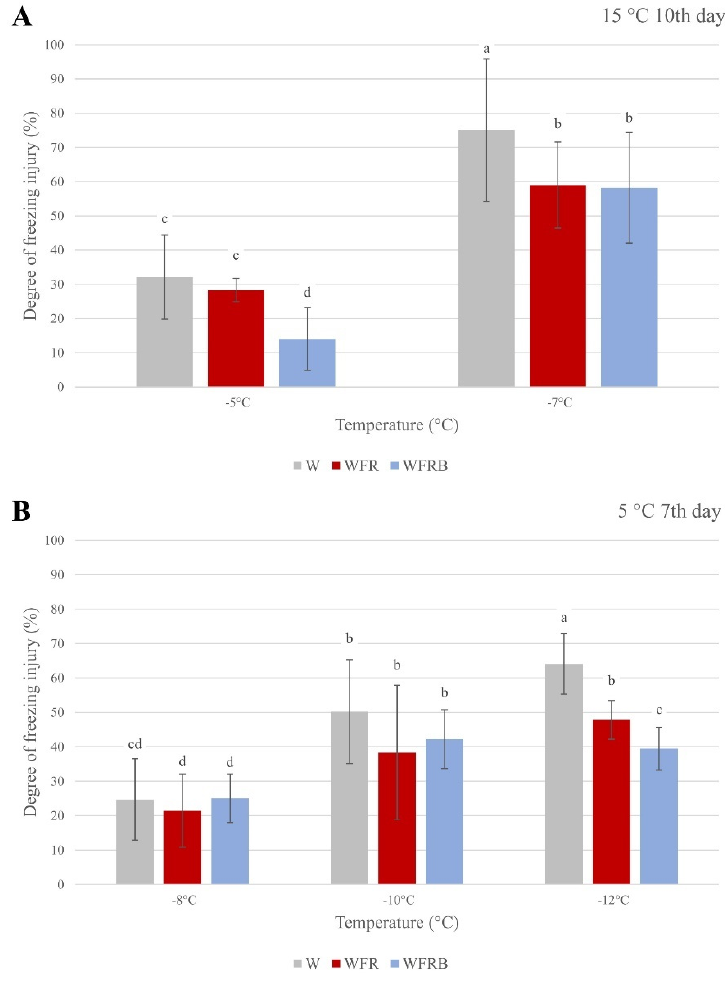
Figure 1. The effects of the supplementary far-red and blue light treatments on freezing tolerance under various temperatures. The X − axis shows the freezing temperatures, whereas the Y − axis refers to the relative conductance values (percentage of lethality). The plantlets were grown under a 12 h photoperiod. W: white light, WFR: far-red-enriched white light, WFRB: far-red- and blue-enriched white light. In each case, the samples were collected on the last day of the treatments. ( A ) 10th day at 15 °C temperature; ( B ) 7th day at 5 °C. The data and error bars, which represent the standard deviation, originated from three biological replicates. Statistical analysis was performed with Kruskal − Wallis test. Values indicated with different letters are significantly different from each other at p ≤ 0.05 levels.